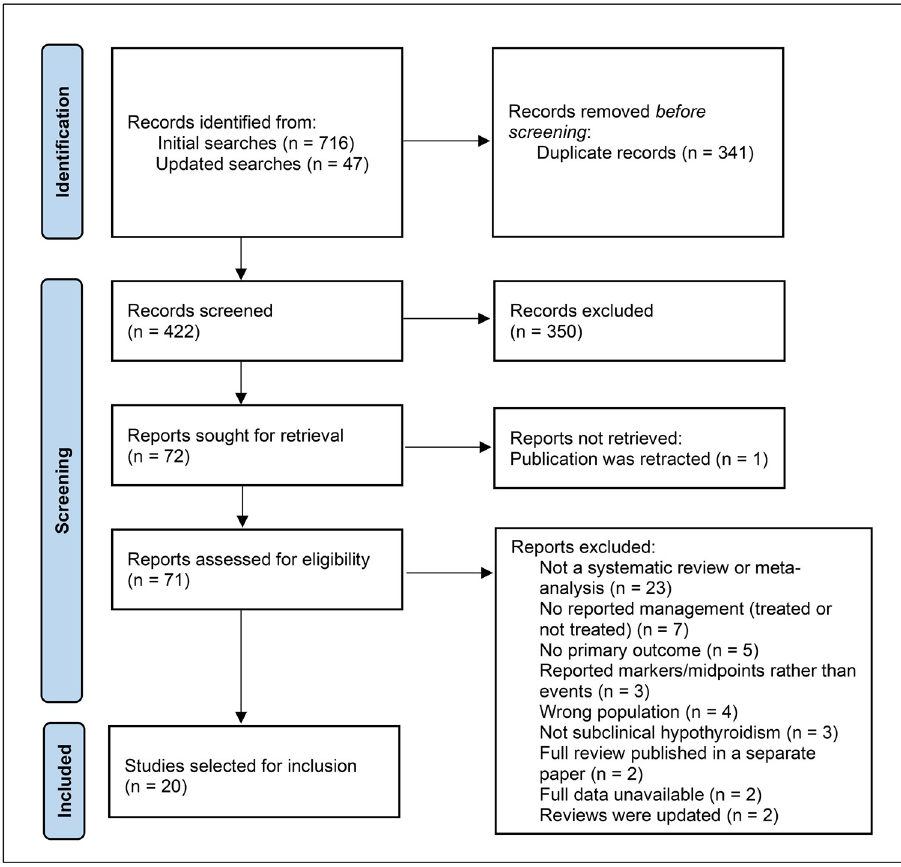
Fig 1. PRISMA flowchart showing study selection (adapted from Page et al. [37]).